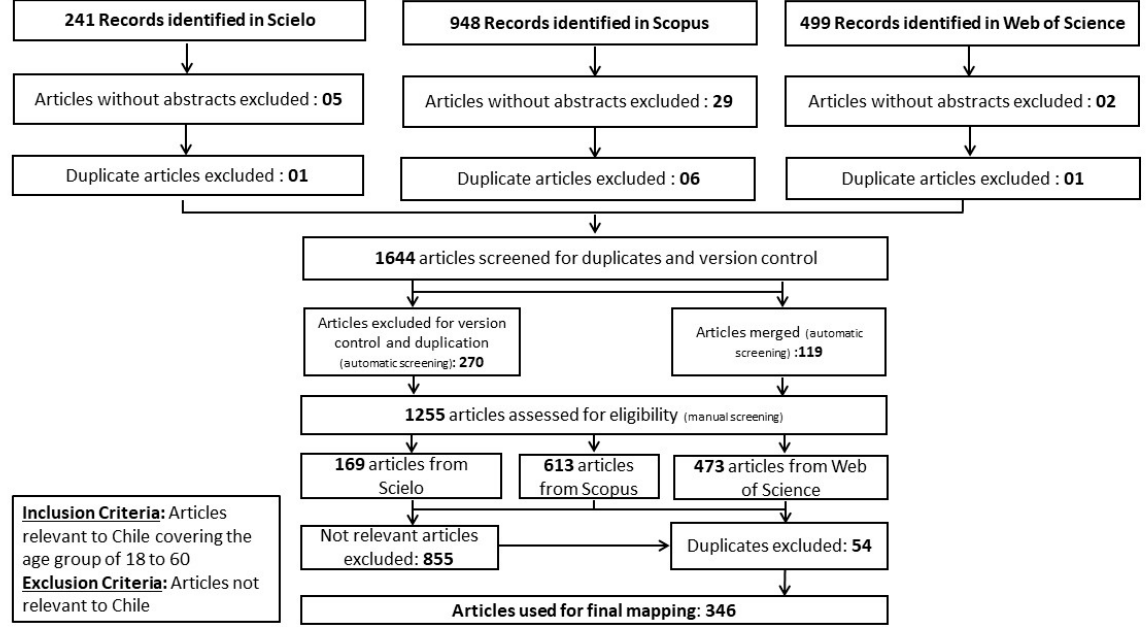
Figure 2. PRISMA flow